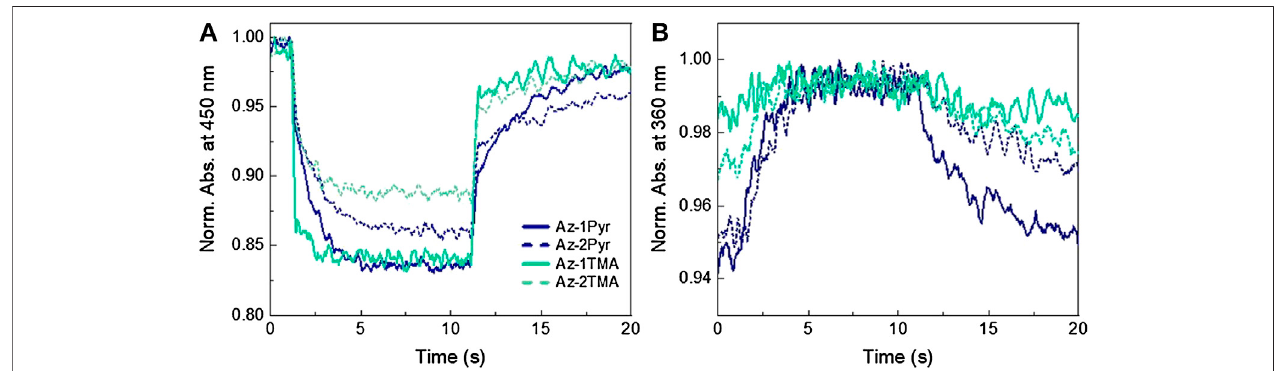
FIGURE 3 | Isomerization kinetics of the azobenzene series in POPC liposomes taken at 450 nm (A) and 360 nm (B) as a function of illumination time. Data were taken through steady-state absorption measurements of the molecules in solution under illumination with a blue LED (470